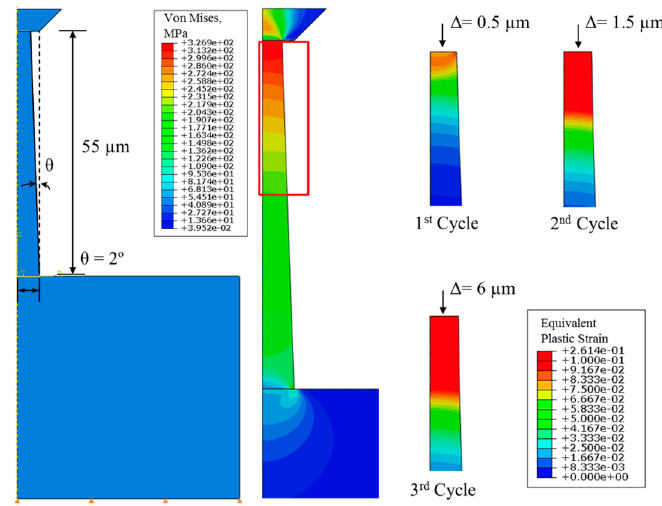
Figure 4. Finite element analysis of micro-pillar experiment, reproduced with permission from [8].